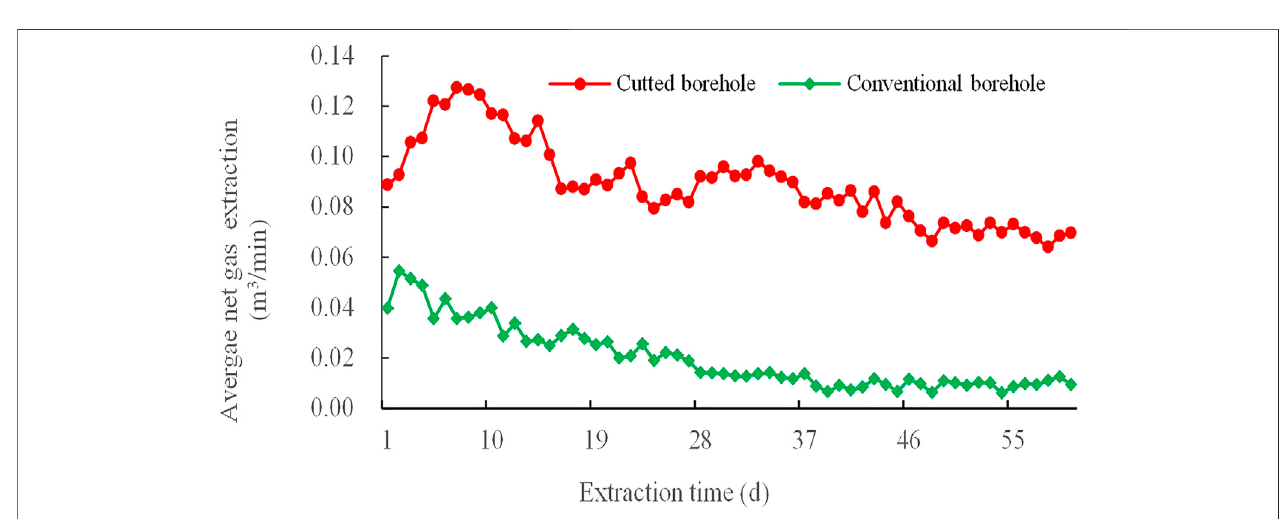
FIGURE 10 | Changes curves of the average net gas extraction from a single borehole for hydraulic cutting and a conventional borehole.